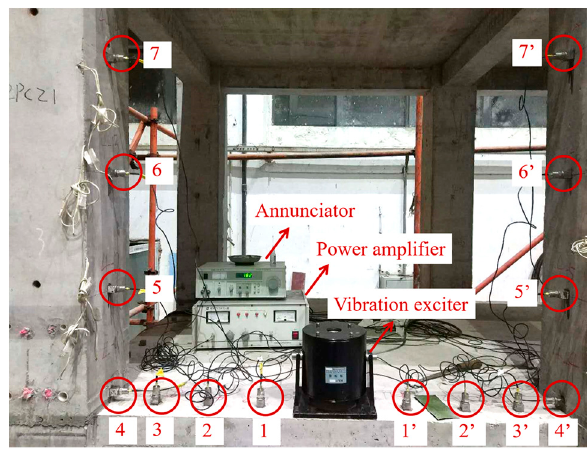
Figure 17. Arrangement of the experimental equipment.